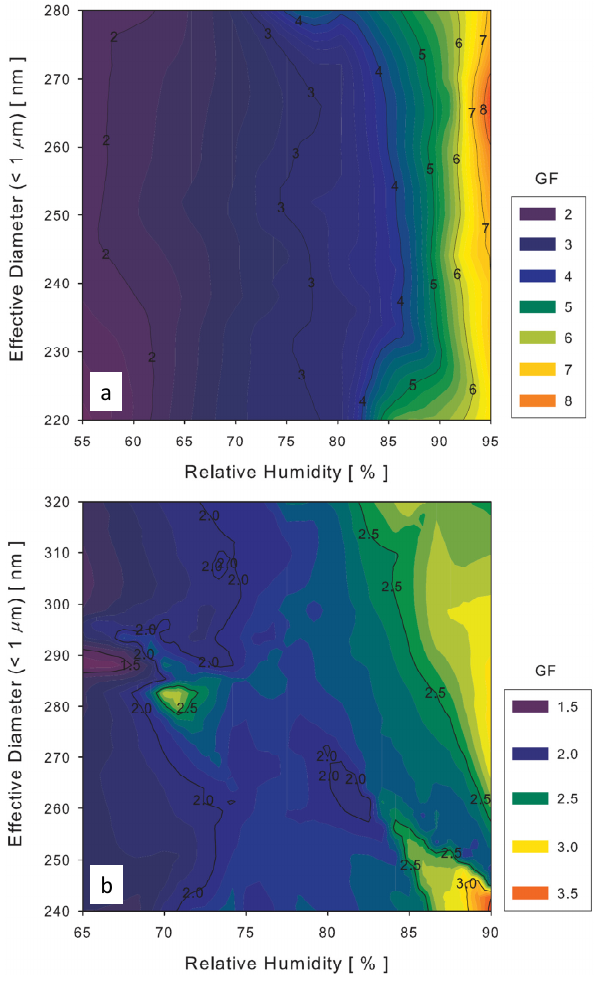
Fig. 13. Contour plots of scattering growth factors ( ξ sp (RH)= σ sp , amb /σ sp , dry ) as a function of relative humidity and effective diameter ( D p, eff ) of the submicrometer particle num- ber size distributions at dry conditions for (a) marine (A1, 23–25 September 2005) and (b) continentally polluted (A4, 6–9 October 2005) cases. The data sets were smoothed by the Loess